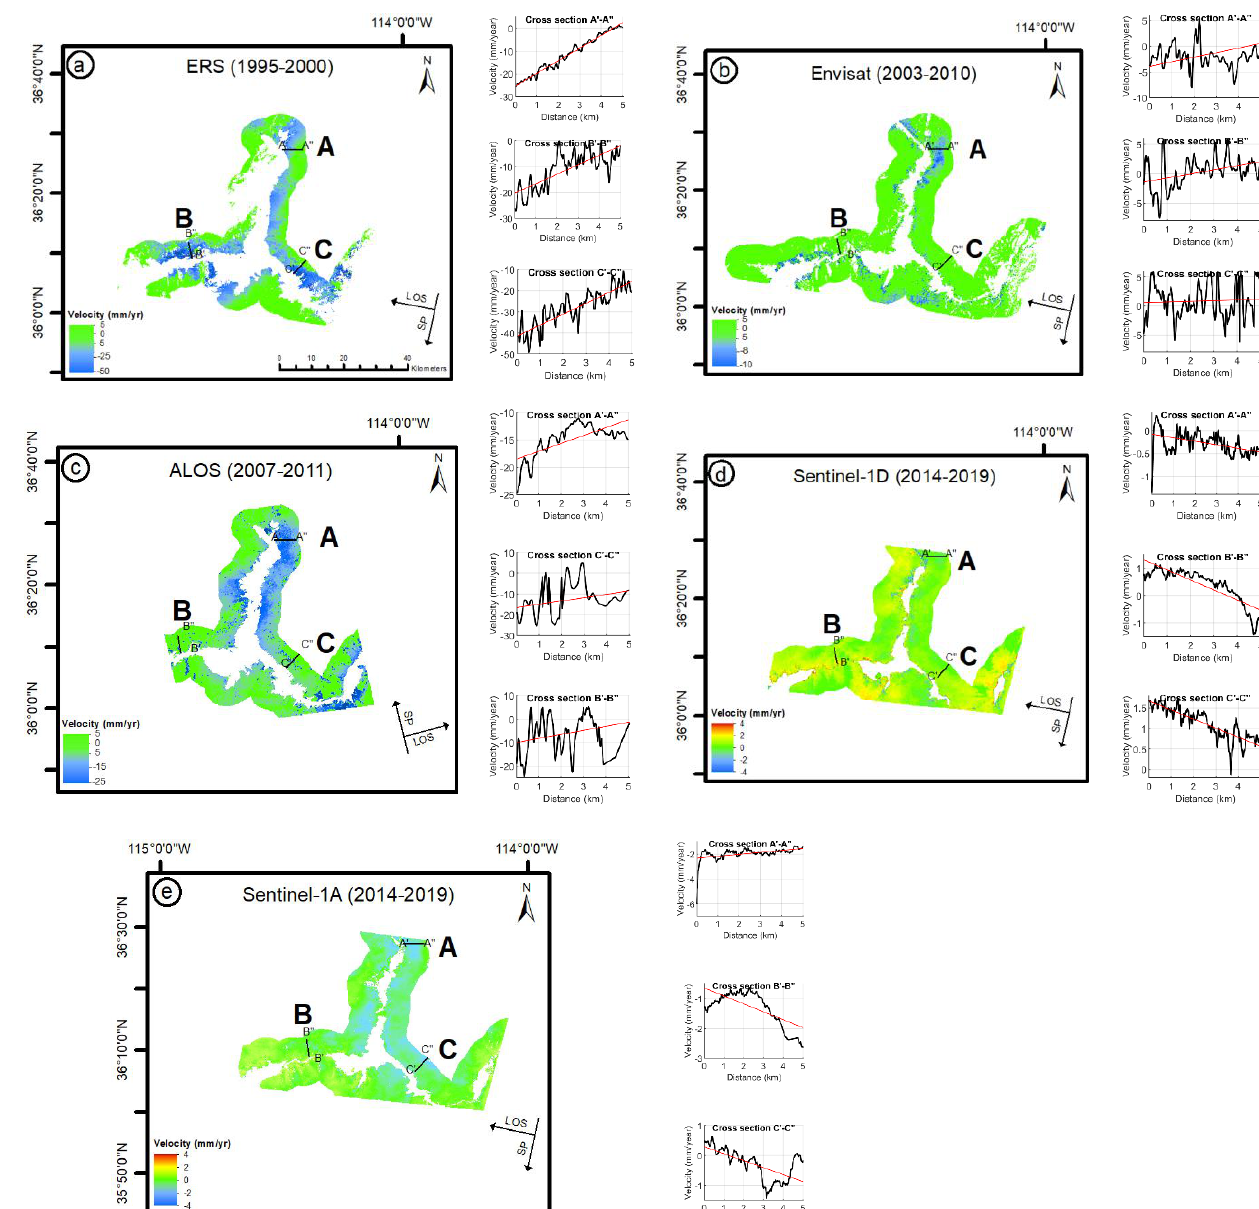
Figure 4. Velocity maps of ground displacement in the buffer zone. LOS velocity maps for ( a ) ERS, ( b ) Envisat, ( c ) ALOS, ( d ) S1D, and ( e ) S1A, each with three small panels on the right showing the ground deformation velocity in mm per year along each transect (i.e., A’ − A”, B’ − B”, and C’ − C”). Overall, the general trend of ground deformation moving away from the reservoir (represented by the red-dashed fitted-lines in all transects of Figure 4) changed